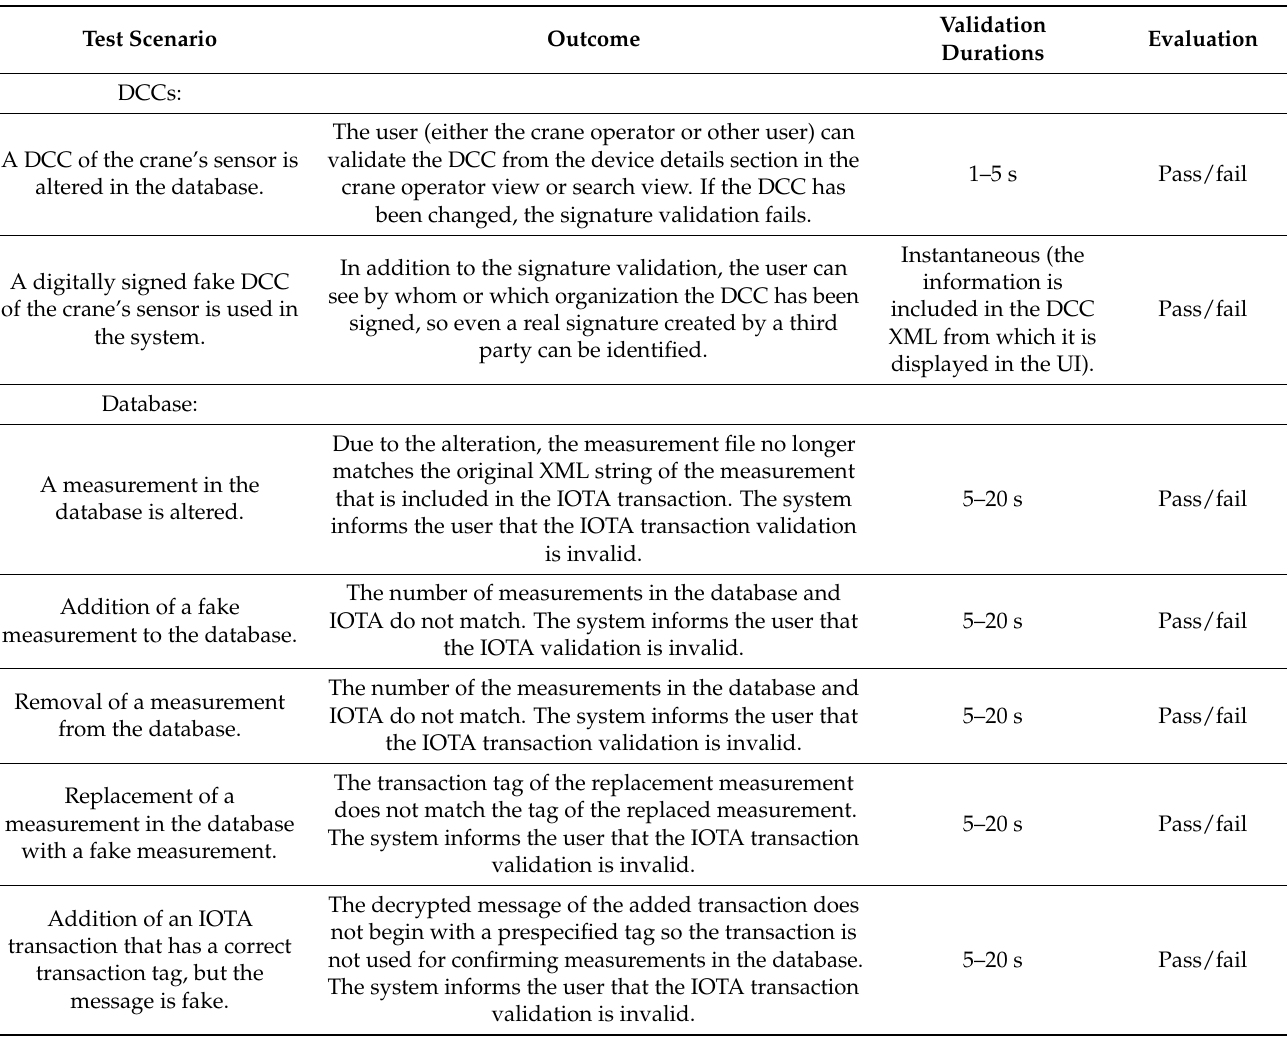
Table 2. Test scenarios used for the validation of the demonstrator. The exact validation durations are dependent on the used hardware. As anticipated, in the case of the demonstrator, all tests were evaluated as